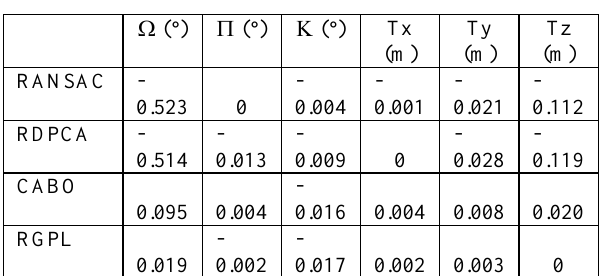
Table 6 Differences between the estimated values with the benchmark values